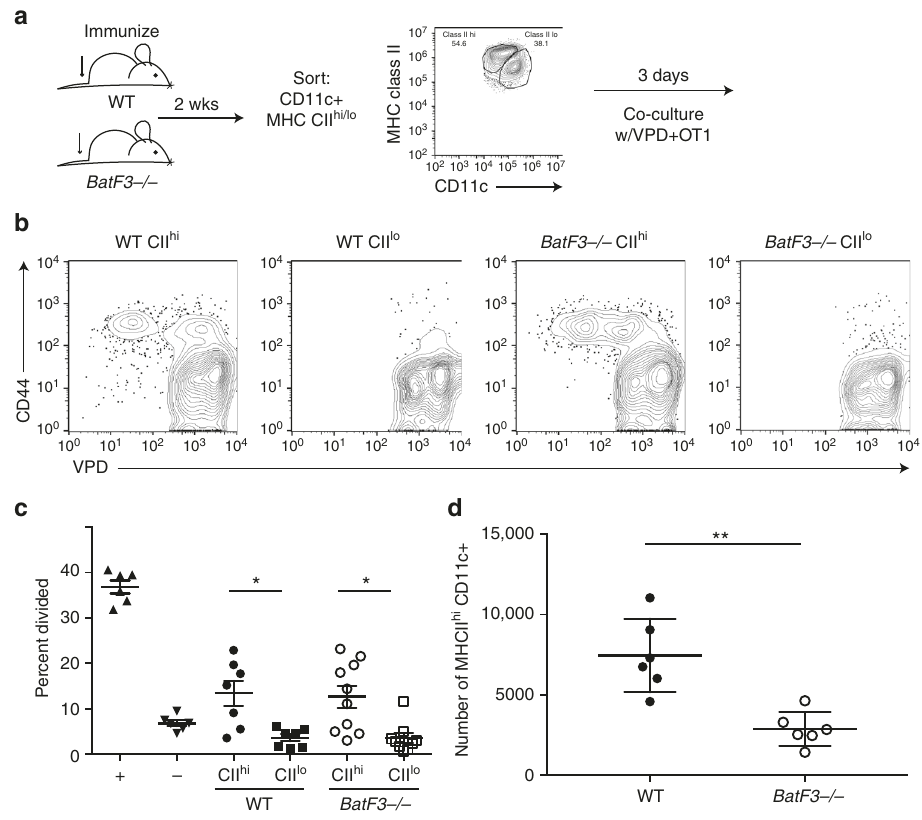
Fig. 4 MHC II hi migratory DCs are required for archived antigen presentation. a Schematic representation of experimental design. WT of BatF3 − / − mice were immunized subcutaneously as above 2 weeks prior to killing. Then lymph nodes were digested, T and B cells depleted, and then sorted on CD11c+ MHC class II high or intermediate expressing DCs. Approximately 20,000 DCs were co-cultured with 50,000 violet proliferation dye (VPD)-labeled OT1s for 3 days. b Flow cytometry of cells from a . Cells were gated on CD8 + , CD45.1 + to evaluate activation (CD44) and division (VPD). c Quanti fi cation of samples from B where + is enriched lymph node DCs from a mouse immunized 1day prior and – is splenocytes from the BatF3 − / − mouse. Experiment was repeated twice. Six mice per group were killed and DCs sorted based on the gating strategy in a . Each point represents one well with 20,000 DCs and 50,000 VPD-labeled cells (based on the number of DCs recovered). Statistical analysis was done using an unpaired t -test where p = 0.0056 for WT and p = 0.0040 for Batf3 − / − . d Lymph node cells from mice above were stained for fl ow cytometry to evaluate the frequency of DCs that were MHC class II high between groups and numbers were calculated. An unpaired t -test was used to calculate the p -value of <